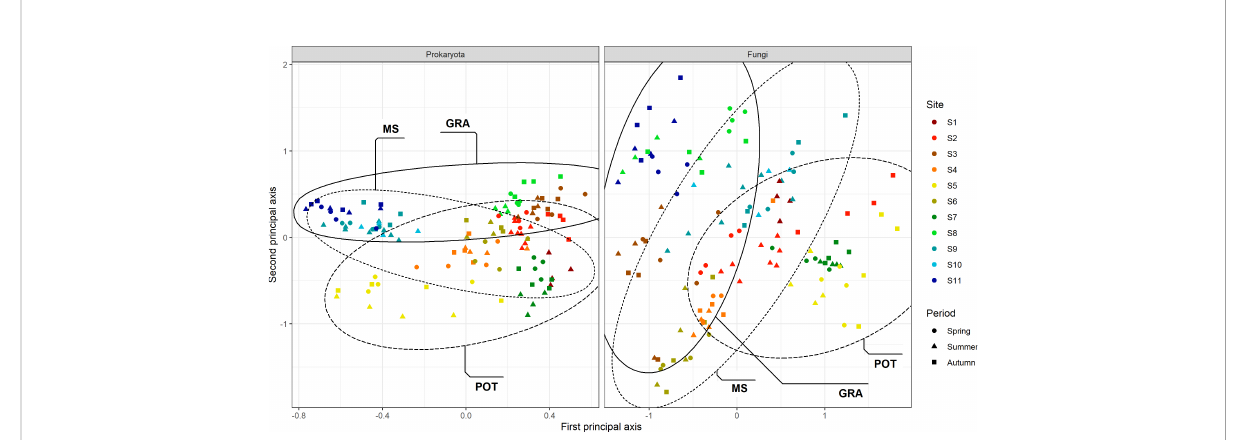
FIGURE 4 Principal Coordinates Analysis (PCoA) of prokaryotic (A) and fungal (B) community composition in bulk soil sampled at each site. PCoA were based on weighted UniFrac distance metric. Crop management codes: (MS: Maize/Soybean; POT: Potato; GRA: Grassland). Colours that are associated with Sites 1 to 11 are allocated according to a soil texture gradient, from the most sandy to the fi ne silt soils (Table 1 and Supplementary